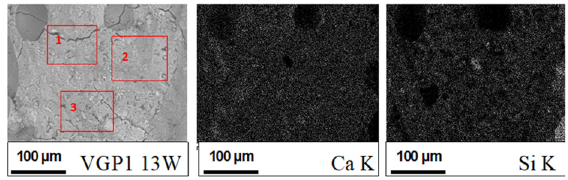
Figure 17. SEM picture of VGP1 specimens and EDX maps for Ca and Si at ×500 magnification. Table 8. Results of fresh concrete.